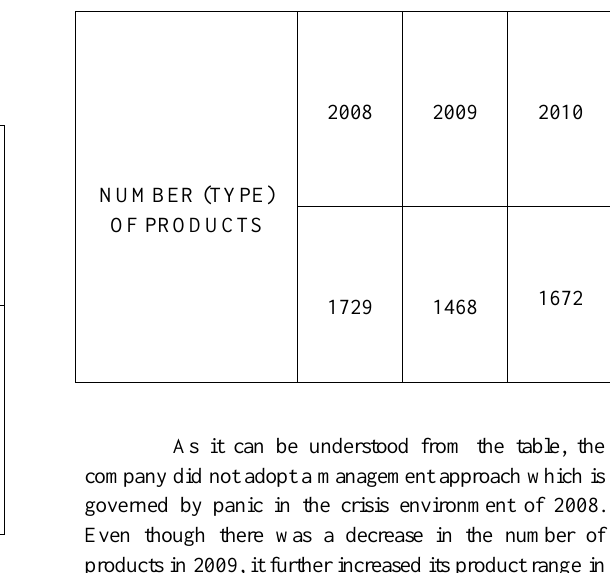
Table 4: Post-Crisis Product Portfolio of